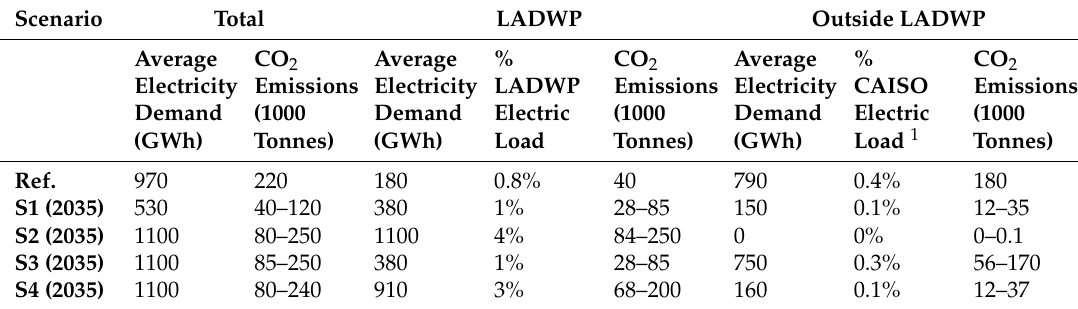
Table 4. Annual electrical electricity demand and CO 2 emissions for the reference year and 2035 projections for all four studies scenarios. Note that percentages of water-related electricity demand, calculated in reference to total electricity demands in LADWP and CAISO regions, are calculated based on LADWP’s 2017 Retail Electric Sales and Demand Forecast [42] and CAISO demand projections reported in California Energy Demand 2018–2030 Revised Forecast [43], respectively. Electricity demand and emissions values are rounded to two significant